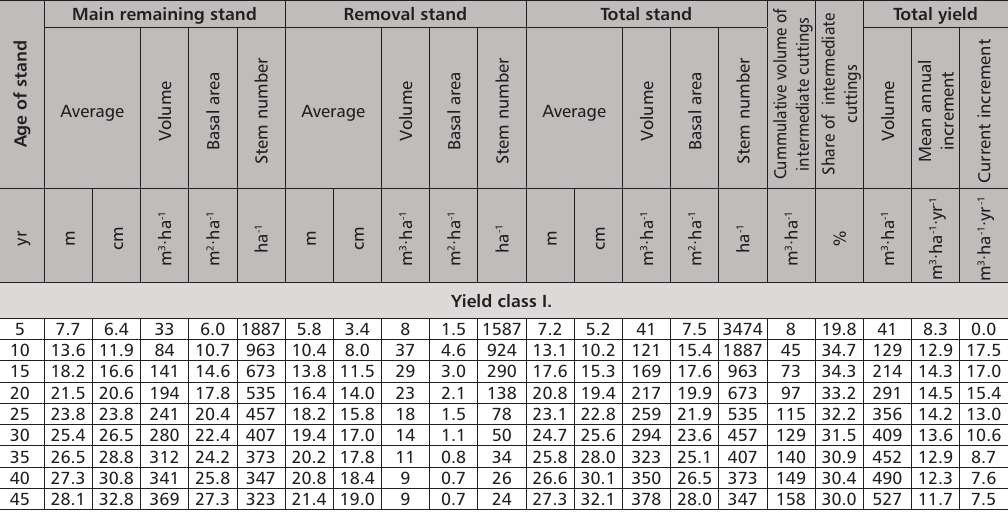
a s t o f g e A